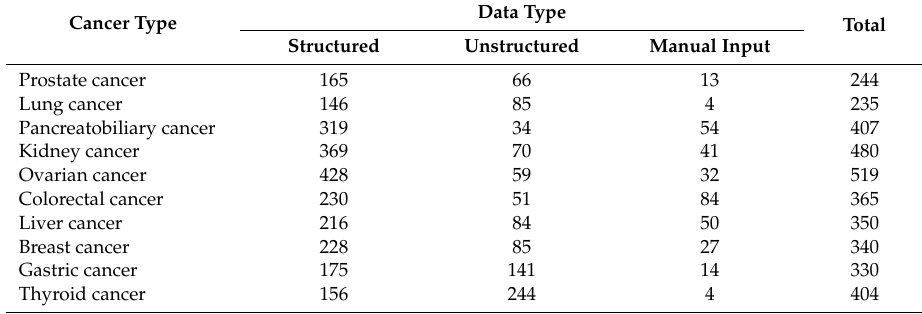
Table 2. Features of structured, unstructured, and manual input data in the clinical cancer registry by cancer